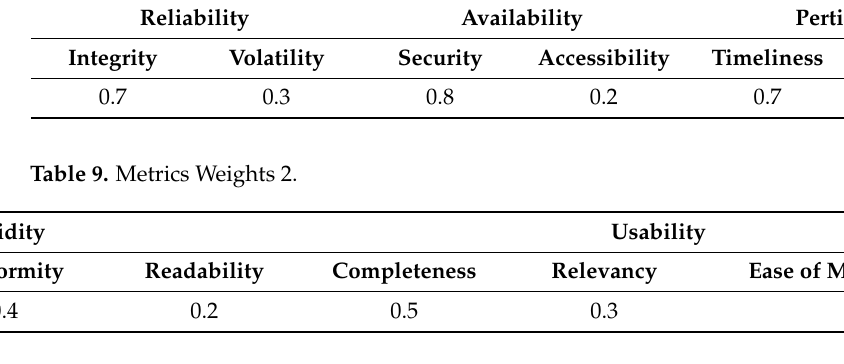
Table 8. Metric Weights 1.